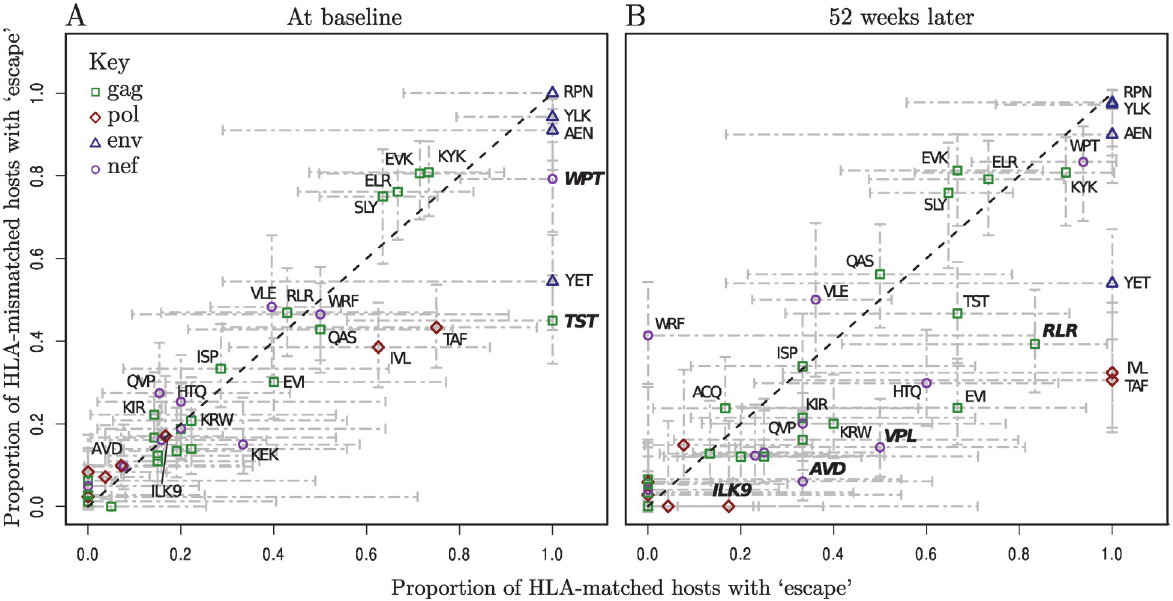
Figure 1. Escape prevalence in HLA-matched and-mismatched hosts. Epitopes are labelled where possible with their first three amino acids, and length if necessary to distinguish them. Bars represent 95% binomial confidence limits (Agresti-Coull method). The dotted black line is y = x . Epitopes labelled in bold have a significantly higher proportion of escape in matched hosts than in mismatched hosts (one-tailed Fisher ’ s Exact test, p < 0.1, note that multiple testing was not corrected for since the purpose of these tests was simply to give a relative measure of significance). Raw data for the number of patients in each category can be found in S3 and S4 Tables. First visit (baseline) sequence data was available in at least one gene for 122/125 patients. The range of time from seroconversion among these patients was 1 – 20 weeks, median 11. (A) At baseline the majority of epitopes have escape at equal prevalence in HLA-matched and-mismatched hosts (B) 52 weeks later within-host evolution has resulted in a higher prevalence of escape in HLA-matched hosts for many epitopes, and in the distribution as a whole HLA-matching and escape are now significantly associated (p < 0.01, permutation test, see Methods for details).